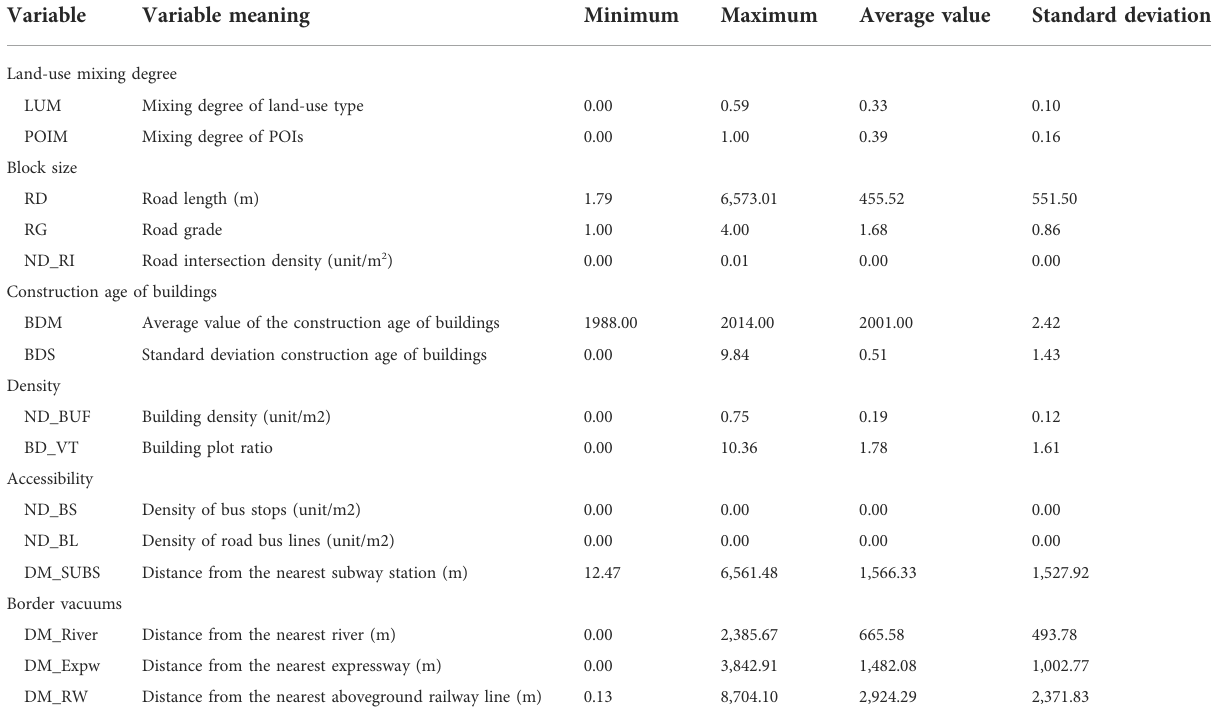
TABLE 1 Basic statistical analysis for built environment